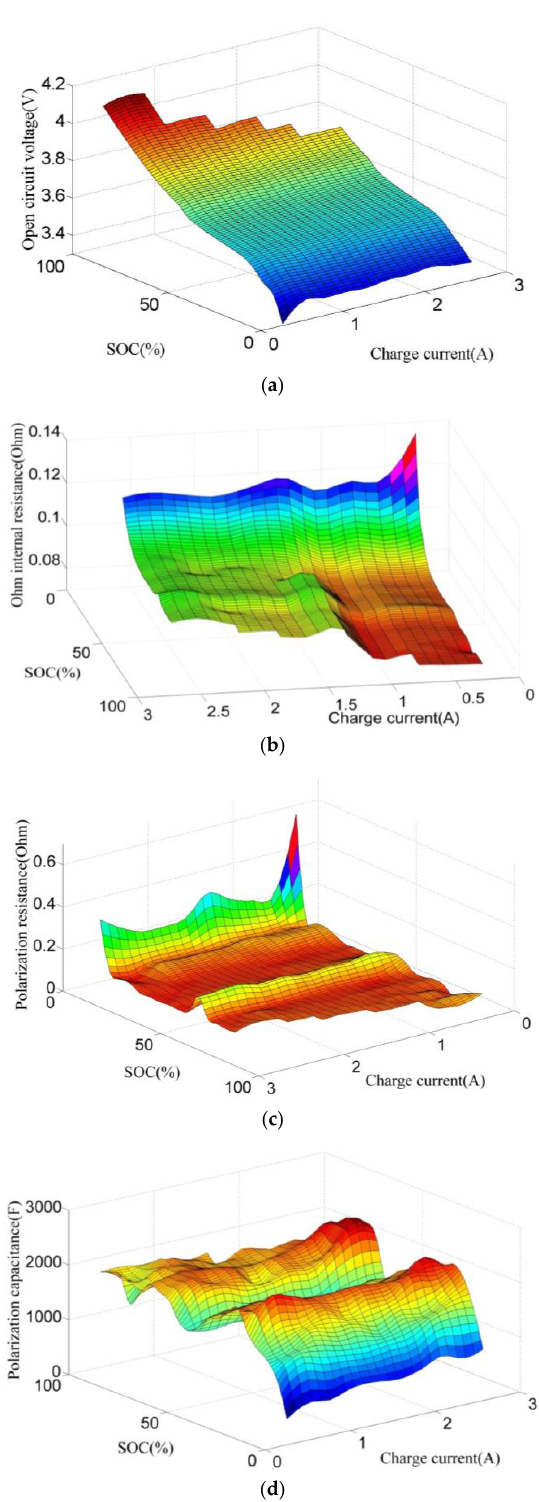
Figure 3. Identification results of battery model parameters. ( a ) Open circuit voltage identification results; ( b ) Ohmic resistance identification results; ( c ) Polarization resistance identification results; ( d ) Polarization capacitance identification results.